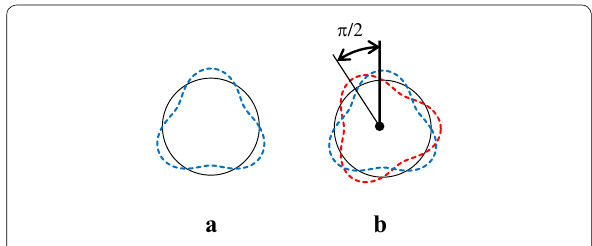
Fig. 1 a Vibration mode exciting three waves along the circumference of a hole in stator. ( a ) The first three-wave mode and ( b ) the second three-wave modes with a wavelength difference of π/